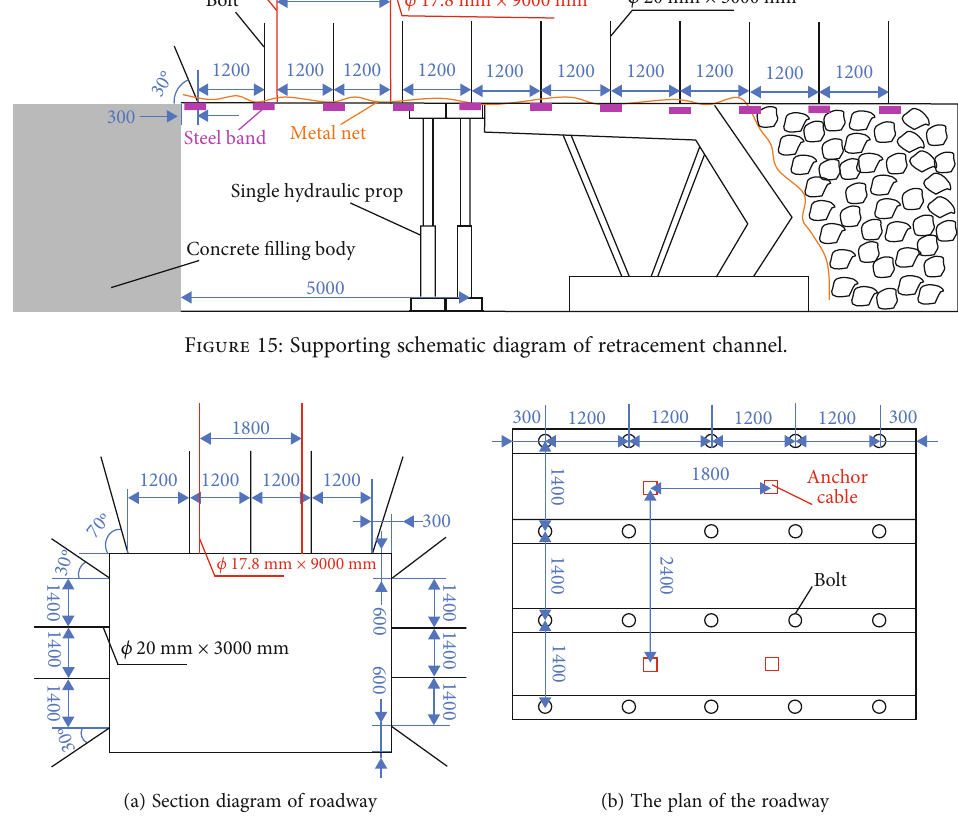
Figure 16: Schematic diagram of support in the auxiliary main haulage roadway.